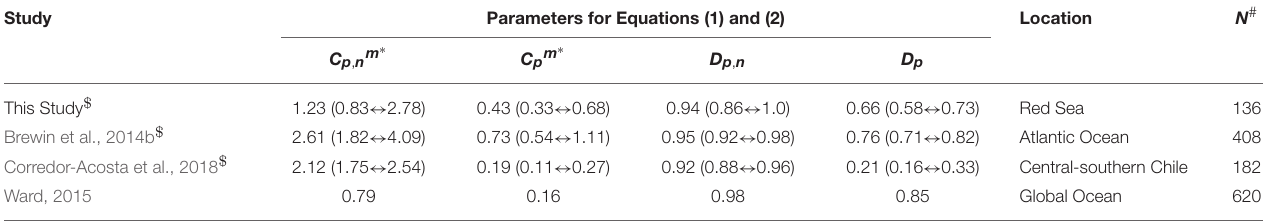
TABLE 2 | Parameter values for Equations (1) and (2) compared with parameters derived using the size-fractionated filtration (SFF) method in other regions. Study Parameters for Equations (1) and (2) Location